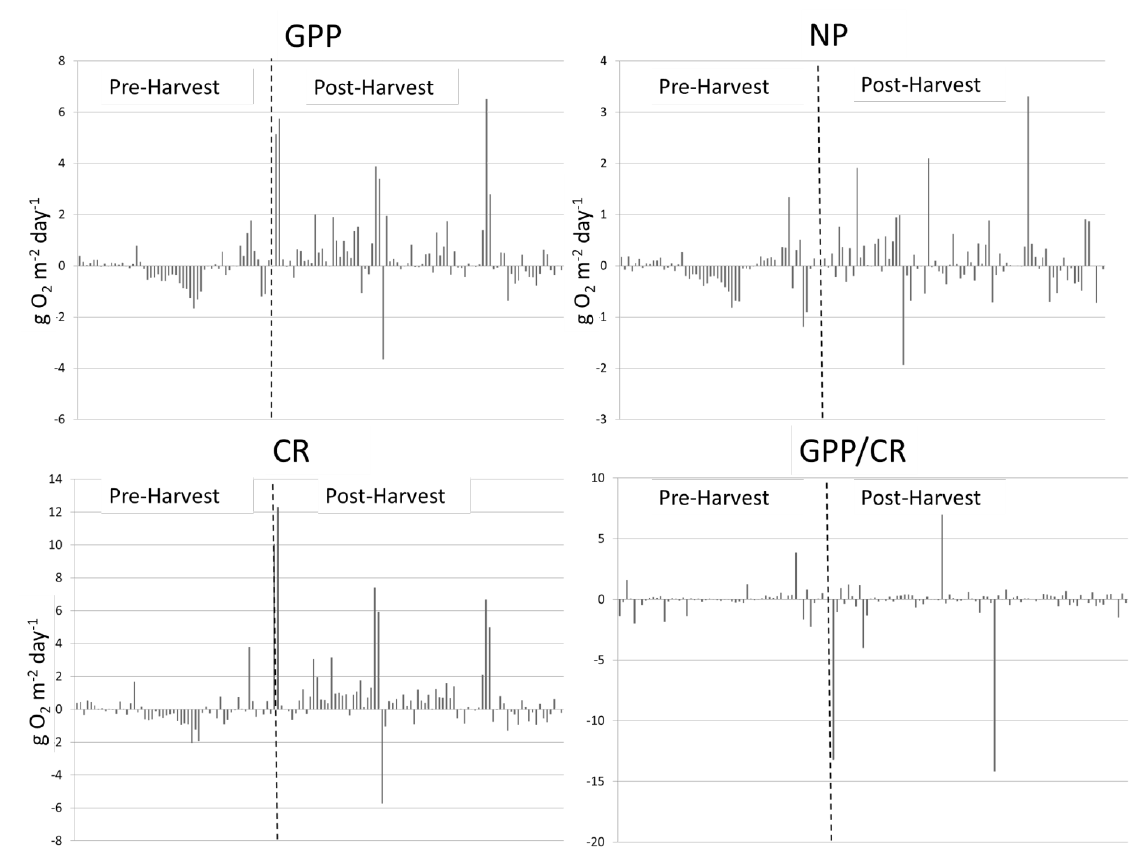
Figure 9. Differences between metabolic variables (N1, N2) over the duration of the study. Pre-harvest and post-harvest data are separated by a vertical, dashed